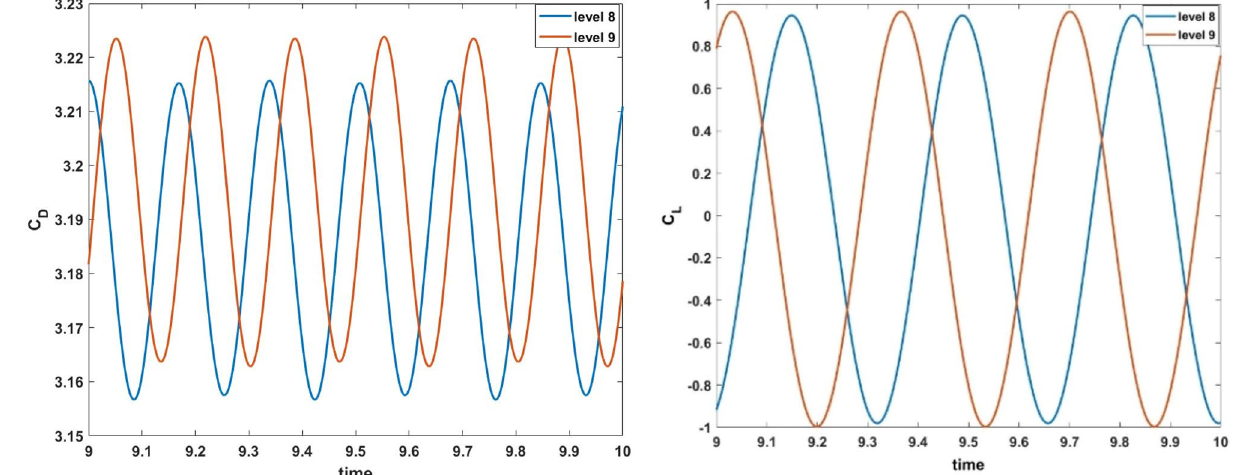
Figure 3. Drag and lift comparison tests for periodic flow at Re = 100 , 33 .